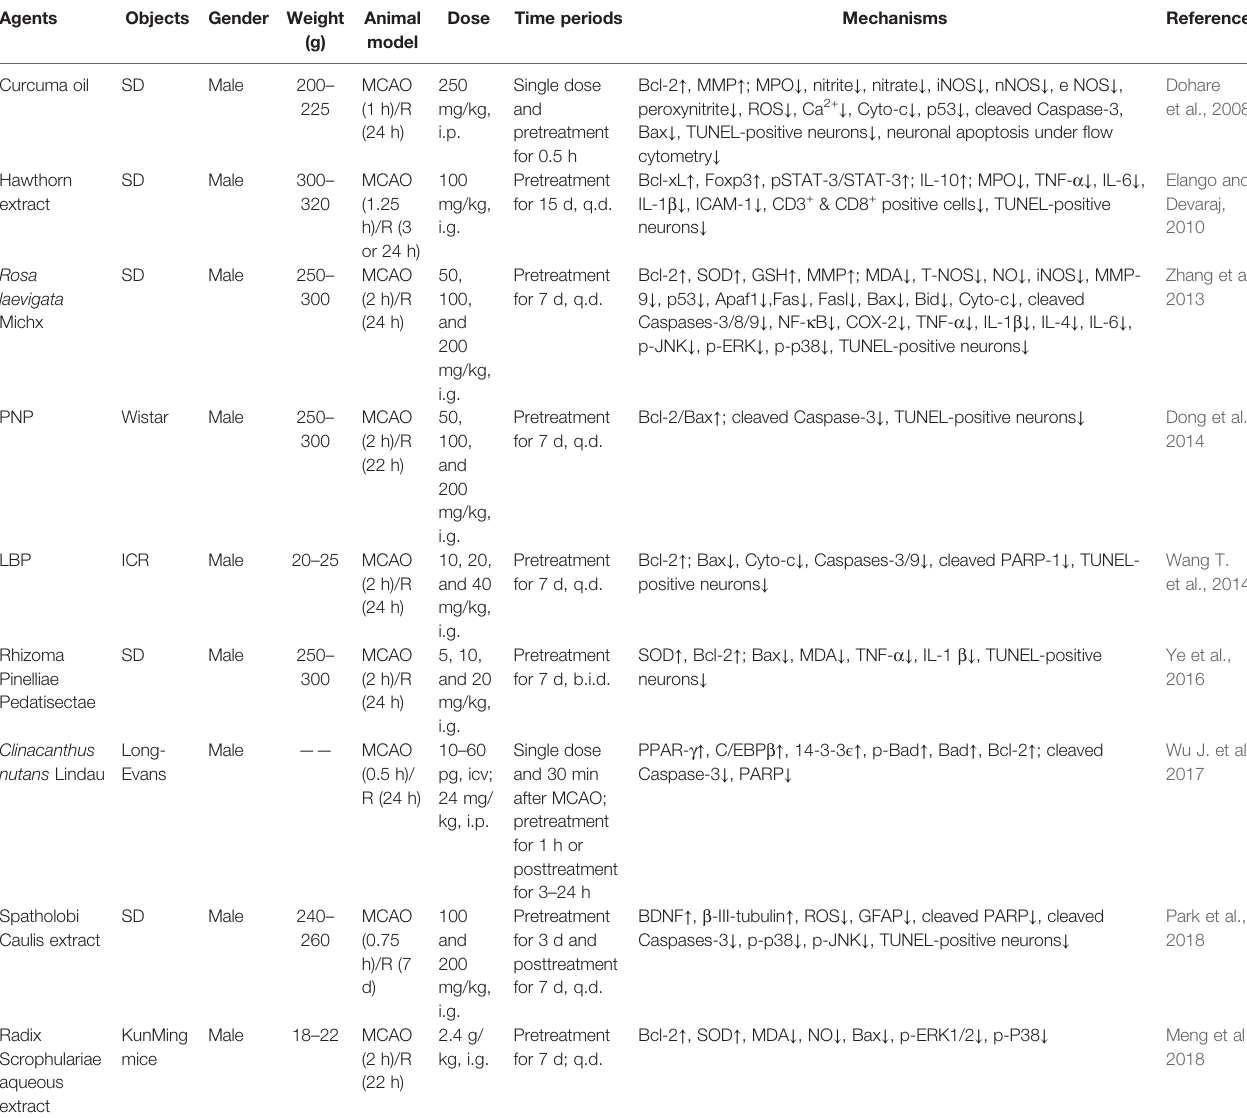
TABLE 4 | The in vivo mechanism underlying the inhibition of MPTP opening-induced neuronal apoptosis by herbal medicine in the treatment of ischemic stroke.